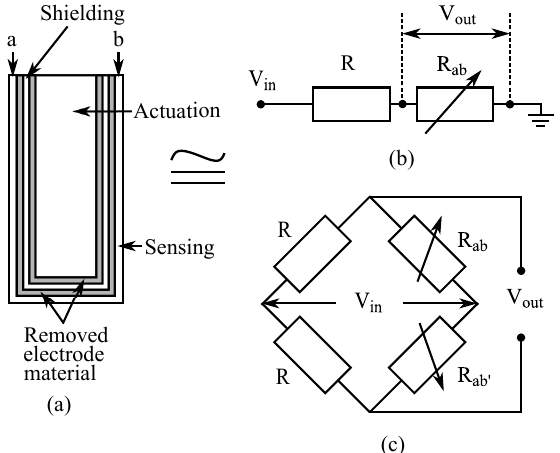
Figure 20. IPMC with patterned electrodes for SSA [10]. R represents the reference resistors, and R ab and R ab (cid:48) represent resistances from a to b on opposite faces of the IPMC. (a) Pattern implementation, where middle segment serves as the actuator, inner contour provides grounded shielding, and the outer contour serves as a resistive sensor. (b) Voltage divider measurement configuration [10,147]. (c) Wheatstone bridge measurement configuration